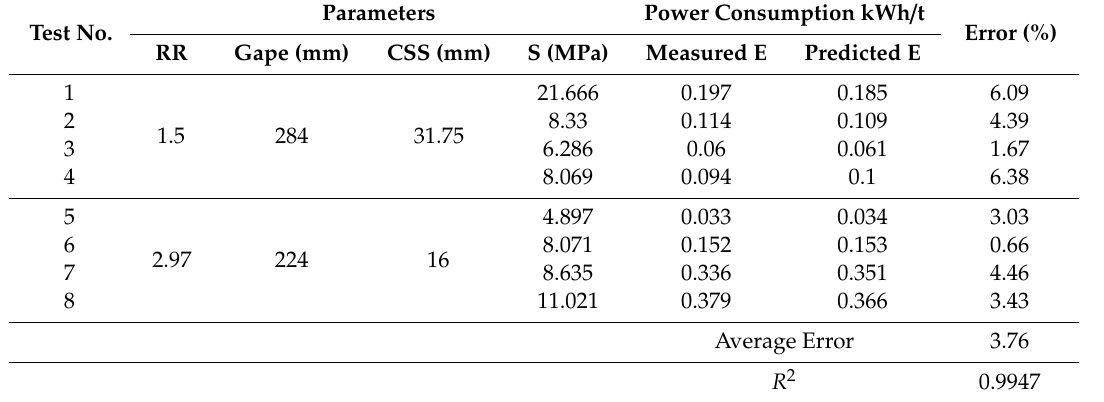
Figure 7. Energy (E) in relation to change of gape (G) and the reduction ratio (RR).